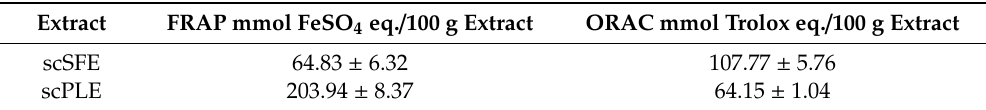
Table 4. Antioxidant capacity of scSFE and scPLE by di ff erent methods: ferric reduction antioxidant power (FRAP) and oxygen radical absorbance capacity (ORAC), giving the antioxidant capacities compared to FeSO 4 and Trolox, respectively. All the results are presented as the mean ± SD. Extract